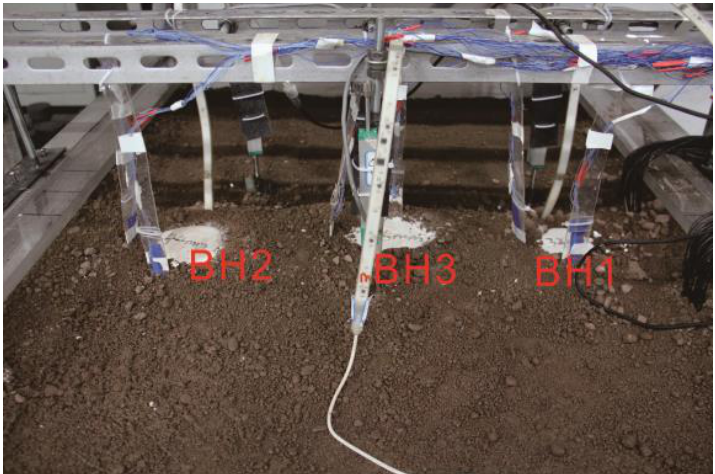
Figure 8. Poured holes after drilling.